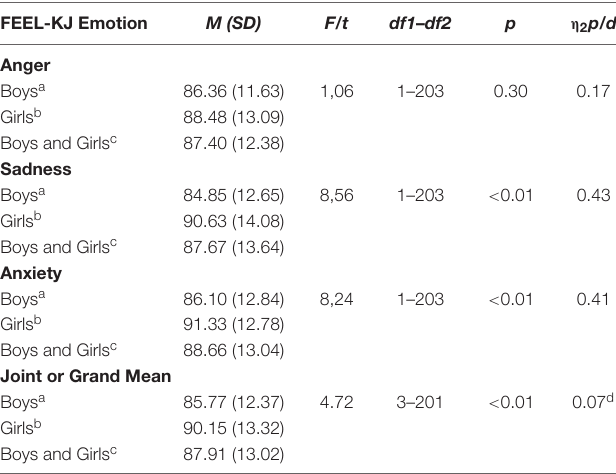
TABLE 6 | Descriptive statistics and hotelling T 2 test results for differences in the FEEL-KJ emotions subscales scores by participants’ age